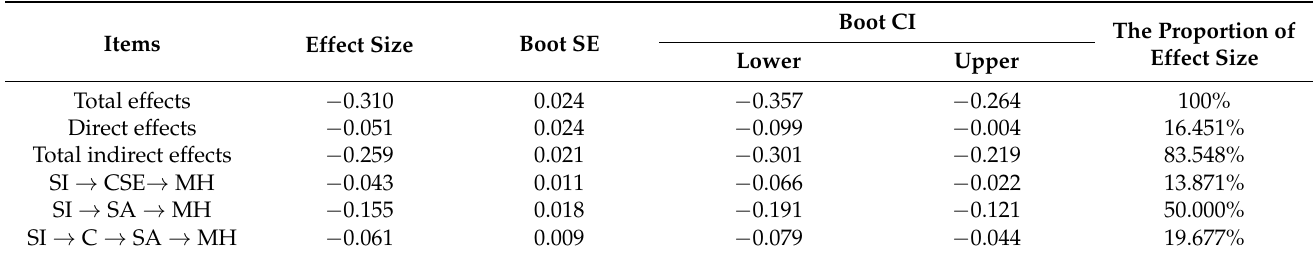
Table 4. Mediating effect analysis of the chain mediating model.